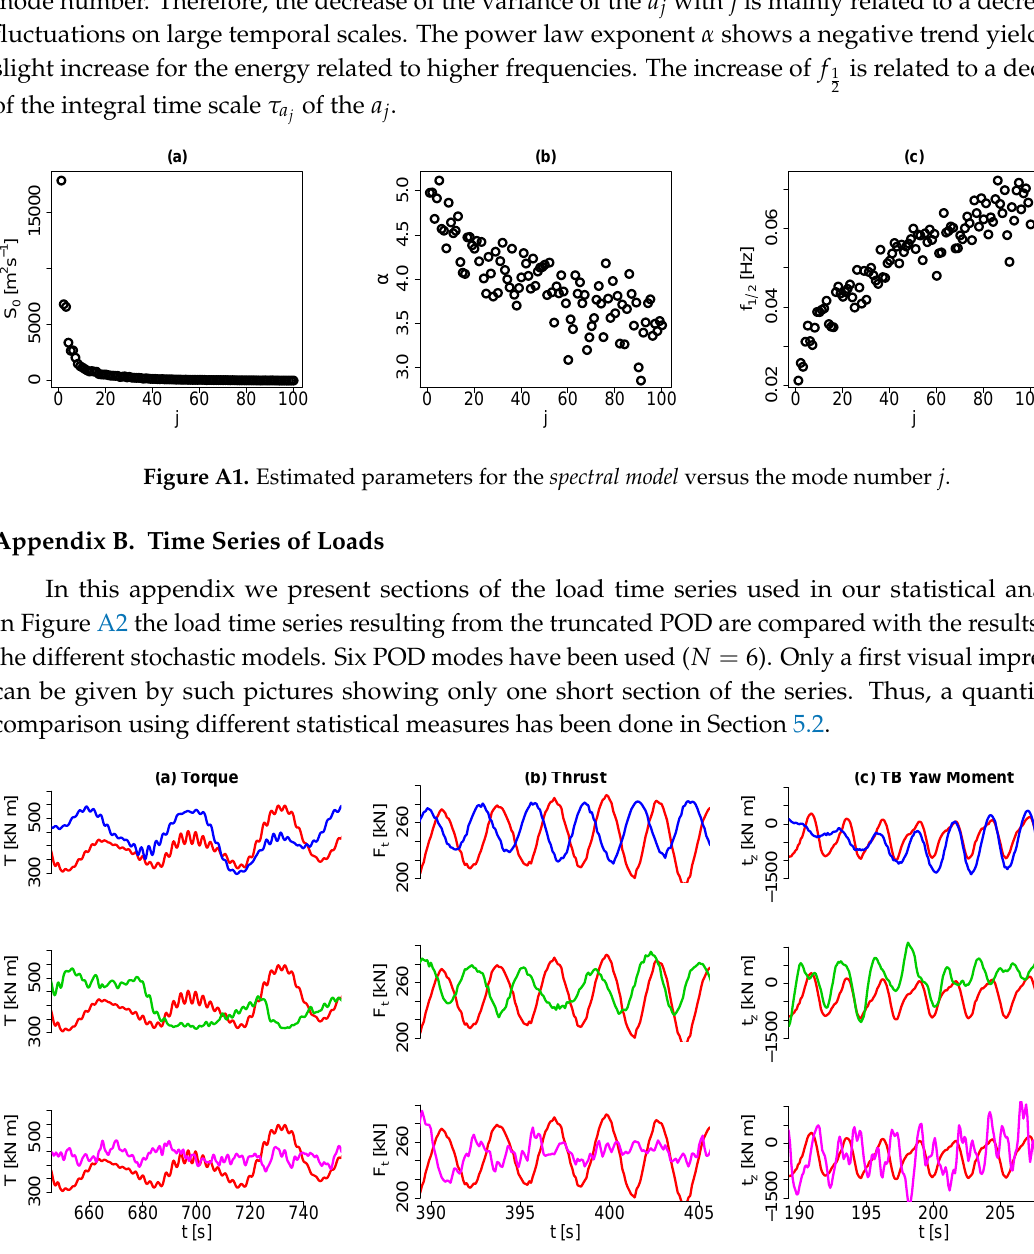
Figure A2. Sections of the time series of the different loads for the truncated POD (red) with N = 6 compared to spectral model (blue), OU-based model (blue), uncorrelated model